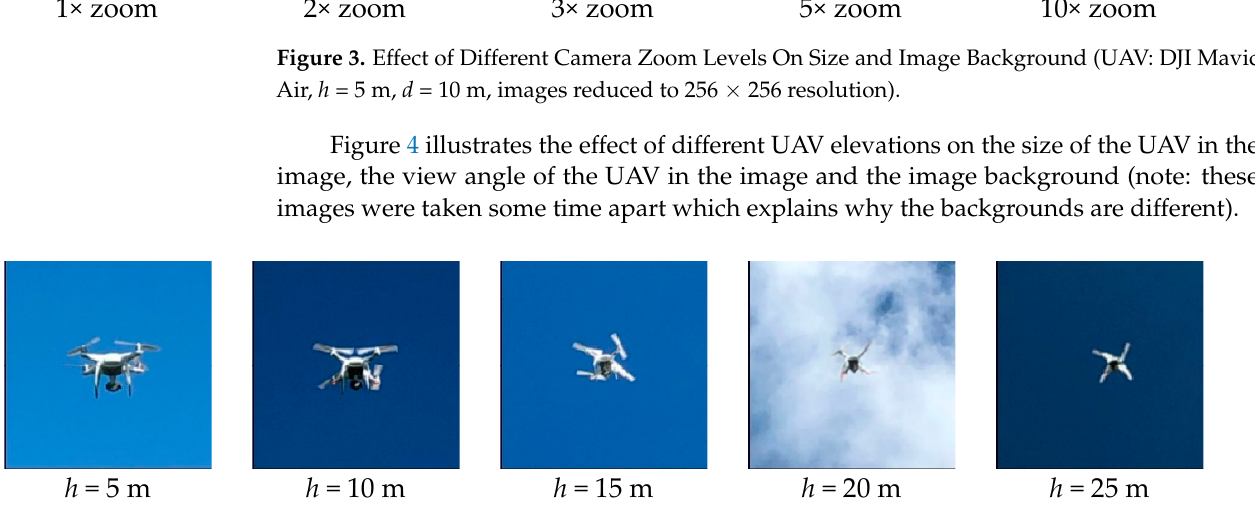
Figure 4. Effect of Different Elevations h on Size, View Angle, and Image Background (UAV: DJI Phantom 4, 10× Zoom, d = 10 m, images reduced to 256 × 256 resolution).